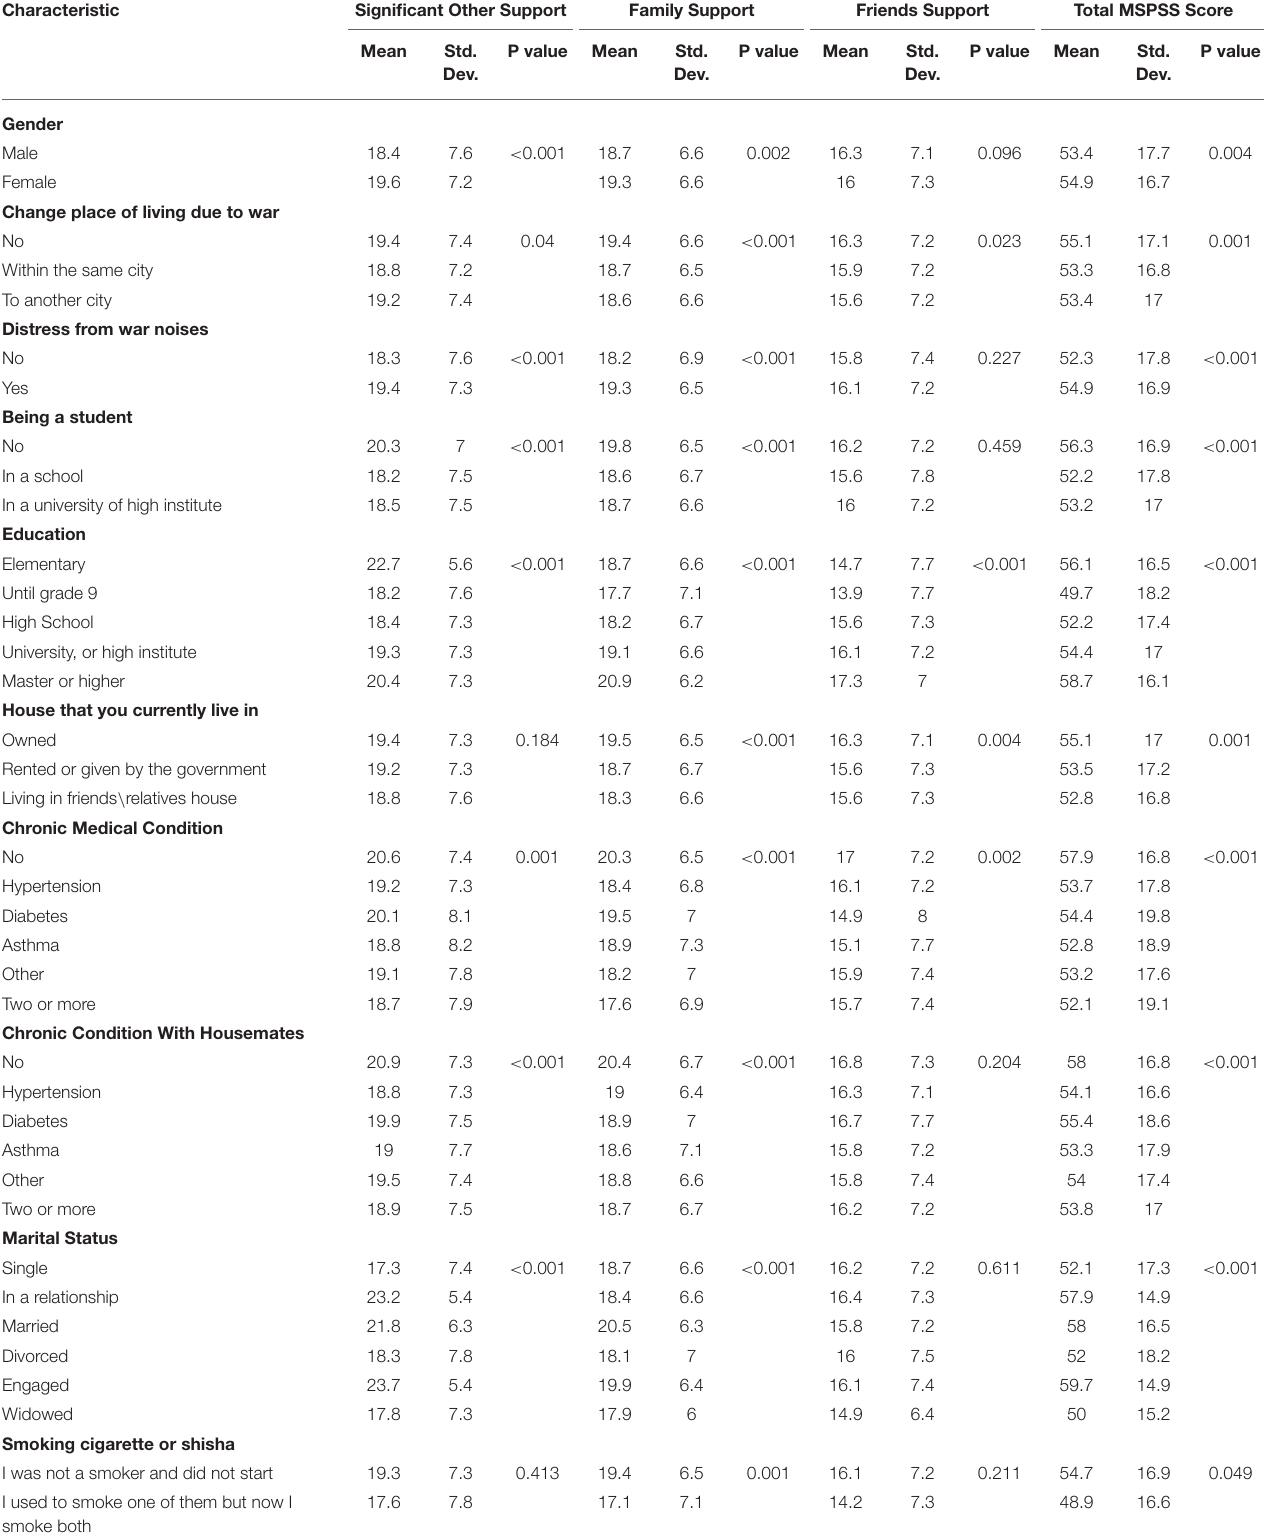
TABLE 4 | MSPSS items and total scores mean scores and correlations with COVID-19 and war variables along with other variables. Characteristic Significant Other Support Family